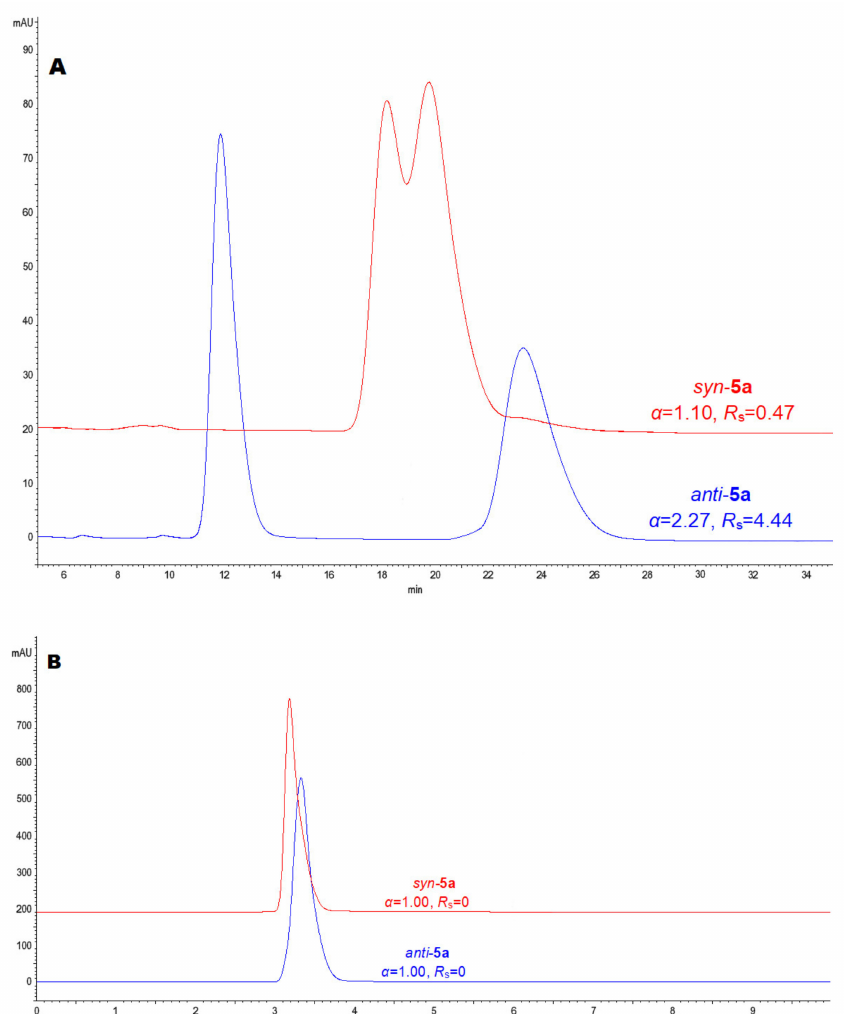
Figure 9. HPLC overlay chromatograms of ( ± )- syn - 5a and ( ± )- anti - 5a on Cellulose-SC column with: ( A ) n -hexane/2-PrOH (90/10, v / v ) and ( B ) 100% DMC as mobile